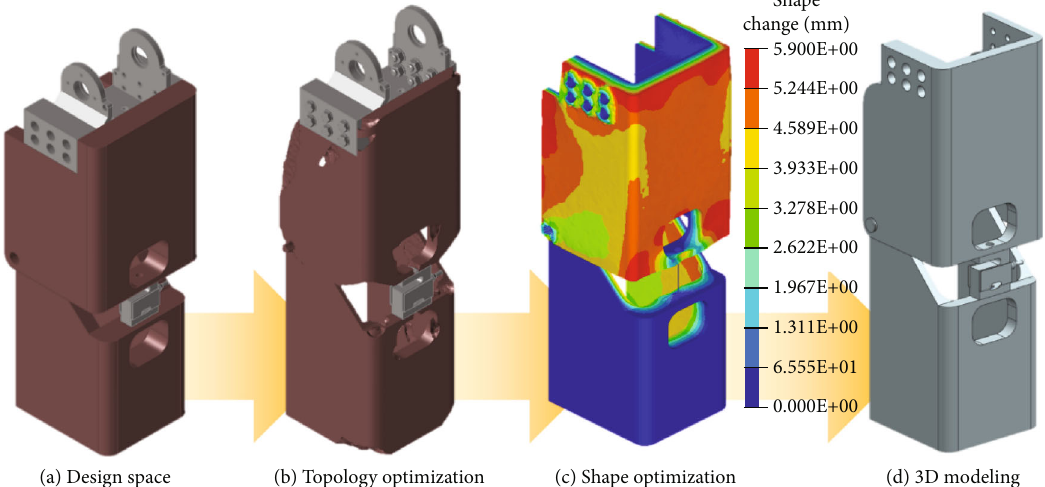
Figure 7: Optimization process for lower-limb optimization.